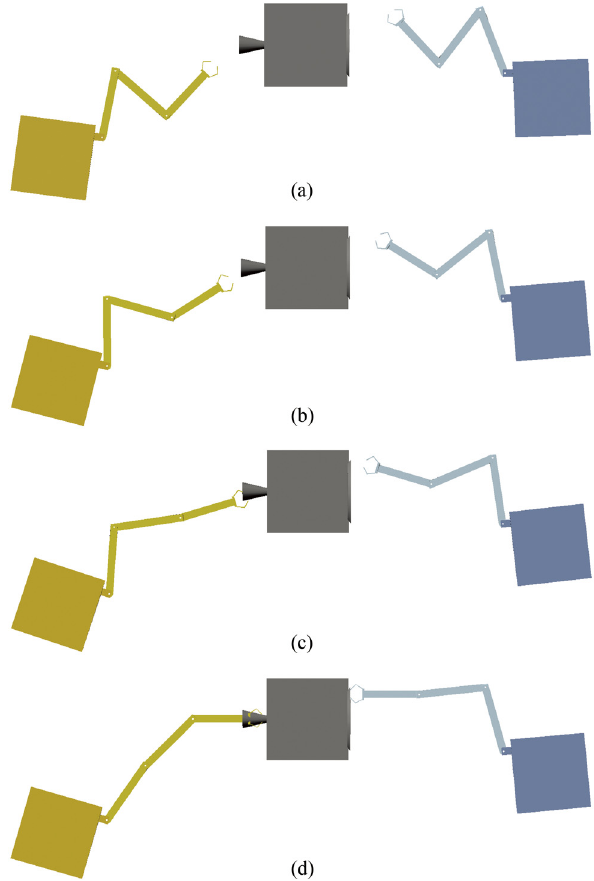
Figure 10: Motion process of the capture system under condition B. ( a ) 3 s, ( b ) 6 s, ( c ) 9 s, and ( d ) fi